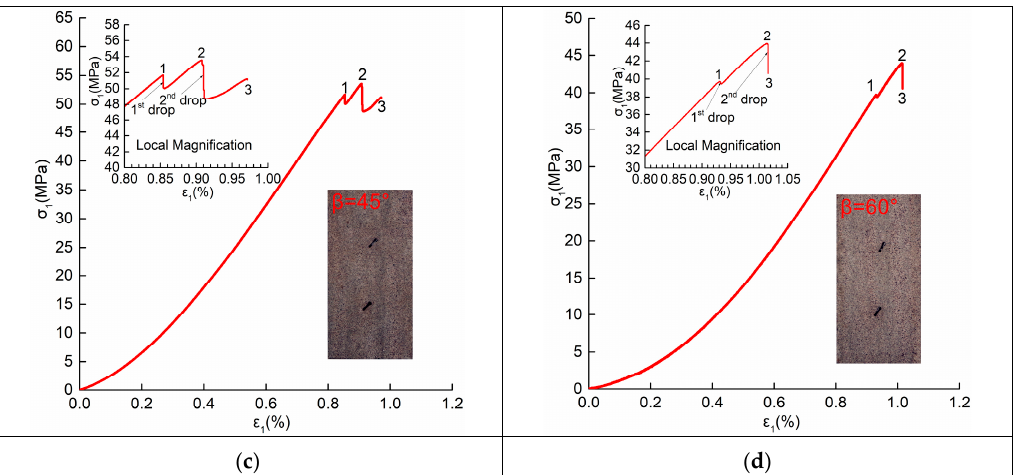
Figure 4. Axial stress–strain curves under uniaxial compression. ( a ) Intact specimen; ( b ) B-30; ( c ) B-45; ( d ) B-60. Table 1. The corresponding stress and strain values of the stress drop points (units: MPa; %; GPa).